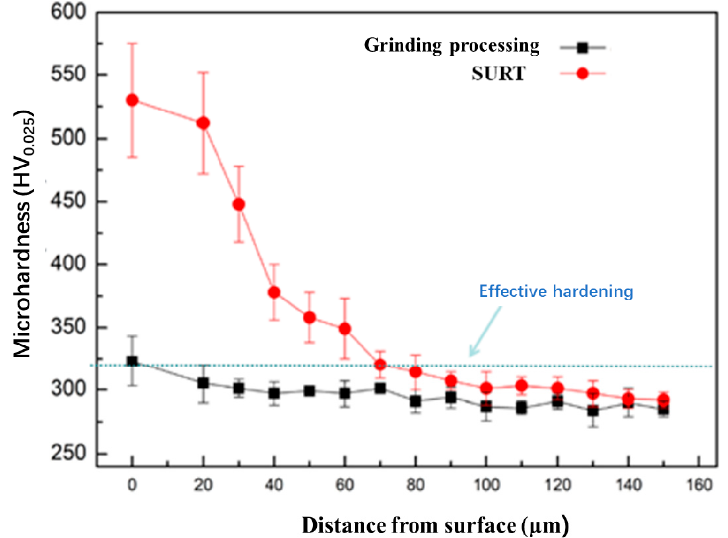
Figure 10. The variation of hardness of the grinding processing sample and the sample after SURT with 0.4 MPa.